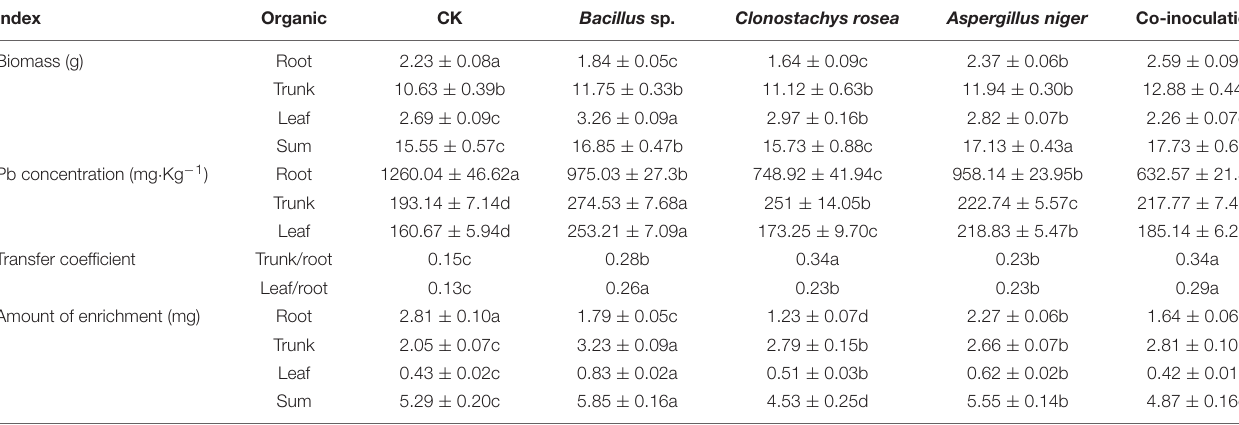
TABLE 2 | Effect of inoculation strains on plant growth, lead extraction, and the transfer